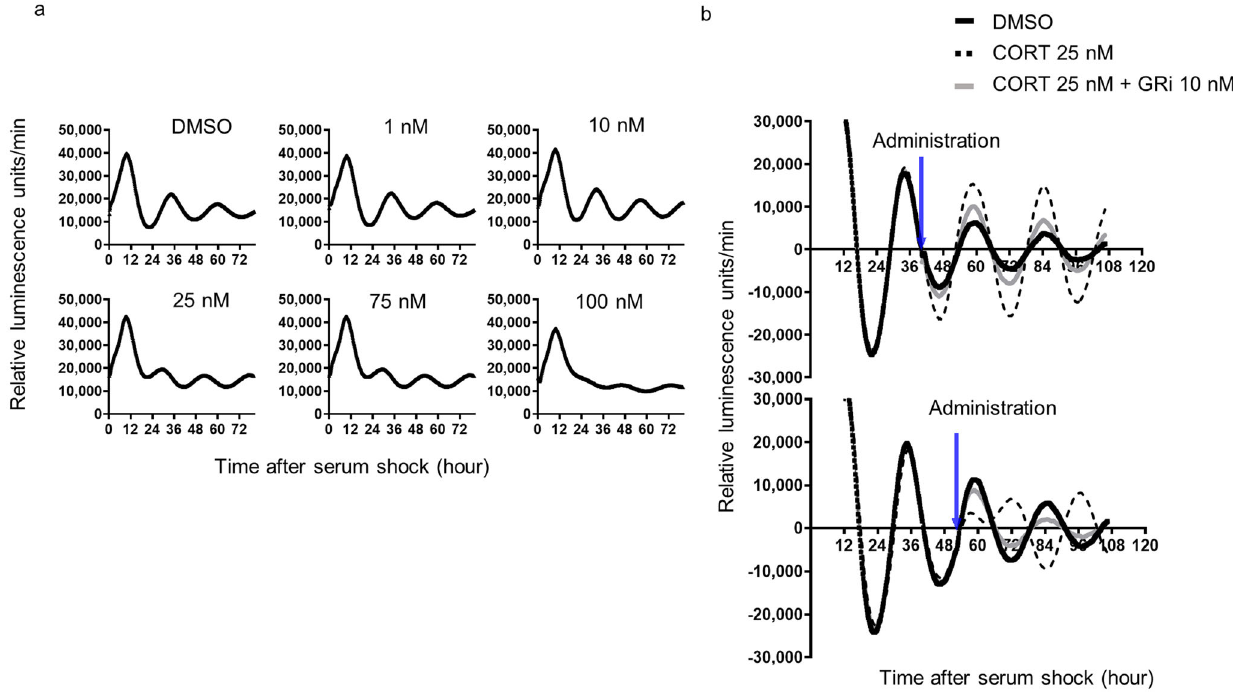
Fig. 2 Bmal1 -Luc cell luminescence intensities with cortisol addition. a Successive changes of luminescence intensities of Bmal1 -Luc cells by adding 1 nM, 10 nM, 25 nM, 75 nM, and 100 nM cortisol to the medium. One representative of two experiments with similar results is shown. b Successive changes of relative luminescence intensities of Bmal1 -Luc cells by administrating 25 nM cortisol and glucocorticoid receptor inhibitor (GRi) at 40 h and 52 h after serum shock (Blue arrows). One representative of two experiments with similar results is